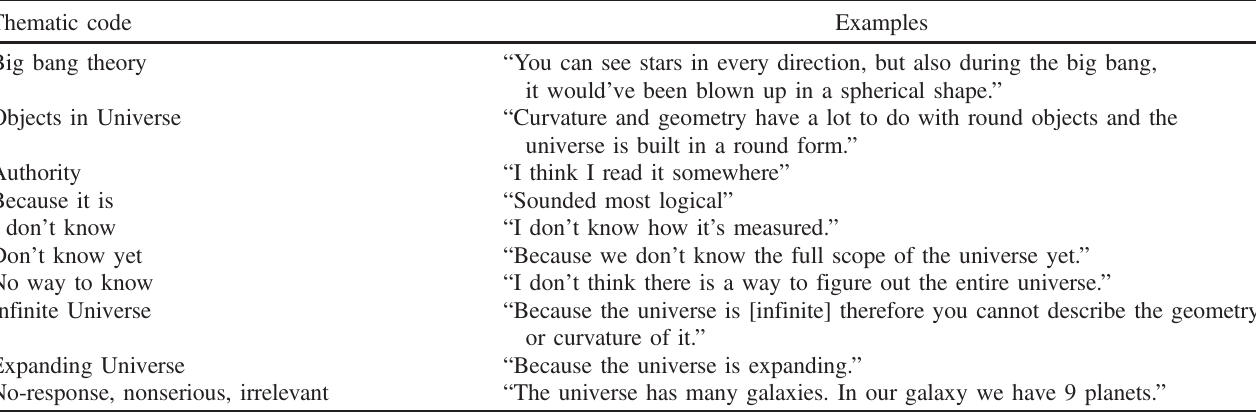
TABLE VI. Thematic coding scheme for preinstruction survey question